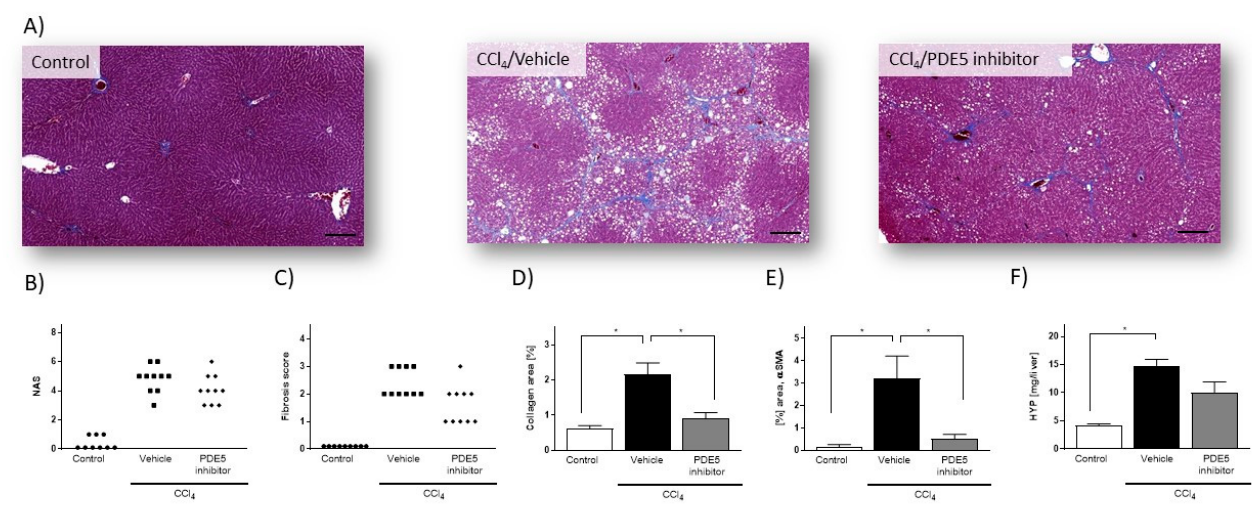
Figure 1. Histology assessment of liver sections from control rats, from rats with CCl 4 -induced liver injury and from CCl 4 /PDE5 inhibitor treated rats. ( A ) Representative images of Masson’s trichrome stain (Masson). (B ) NAFLD activity score (NAS). ( C ) Fibrosis scores. Data in ( B ) and ( C ) represent scores of individual animals ( n = 9–10). ( D ) Image-based quantification of collagen-positive area in Masson’s trichrome stained liver sections. ( E ) Hepatic α SMA content. ( F ) Hepatic HYP content. Data in ( D – F ) represent mean ( n = 5) ± SEM, * p < 0.05; scale bar: 100 µ m.